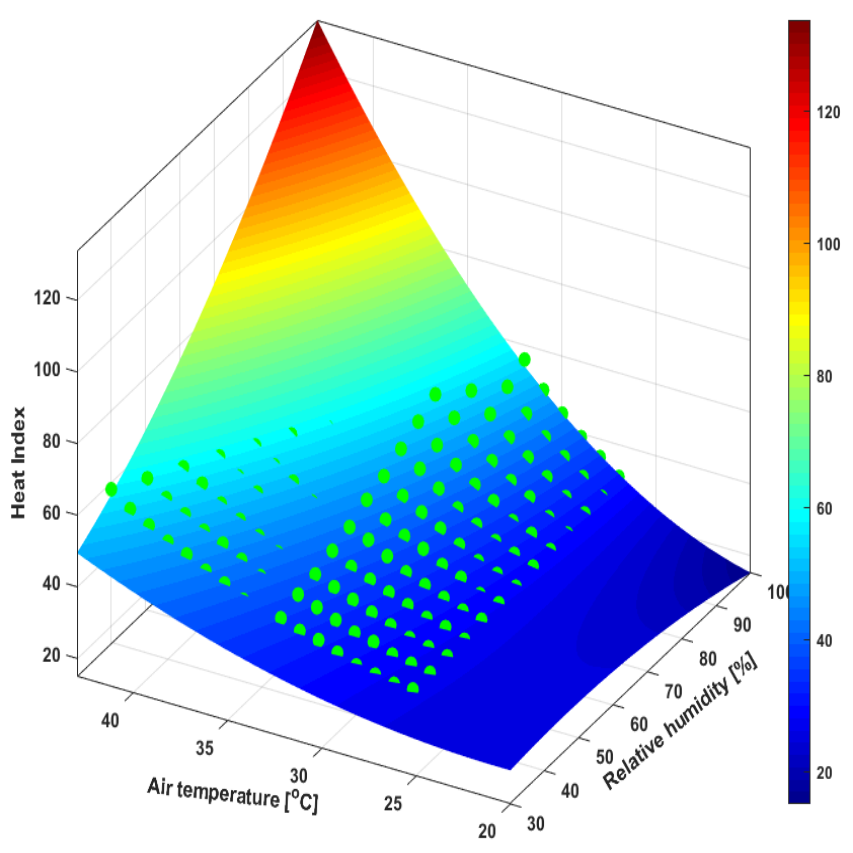
Figure 10. Heat index surrogate model—the green dots are the tabulated values of the HI according to [38,39]. Those values are interpolated according to the surrogate model in Definition